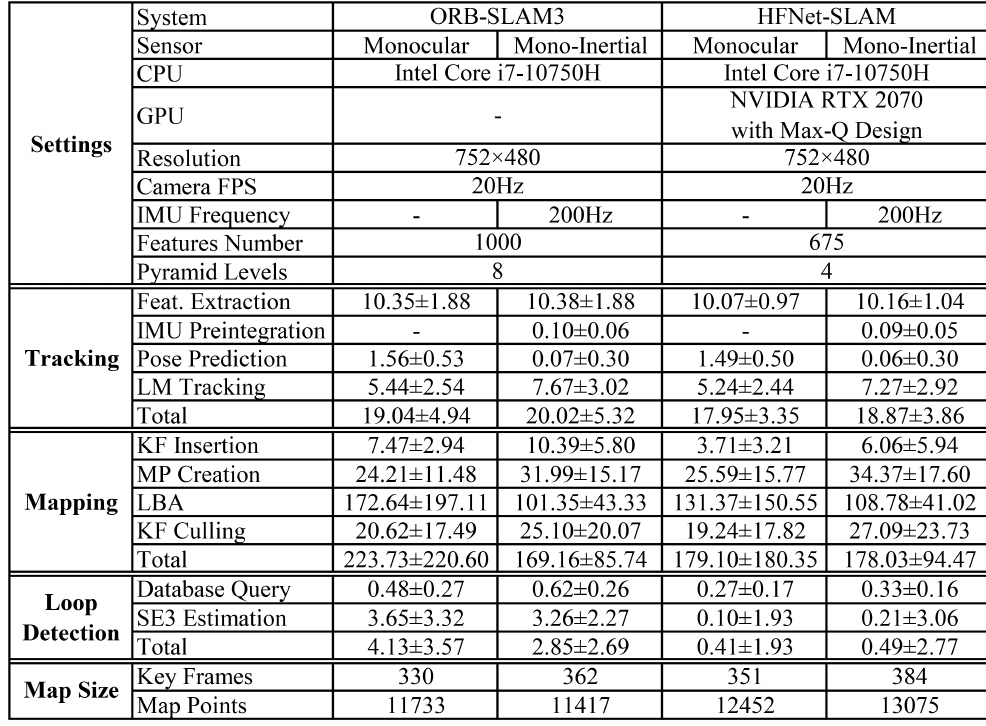
Figure 11. Processingtime of the main components of HFNet-SLAM compared with ORB-SLAM3, on EuRoC V202 (Time in